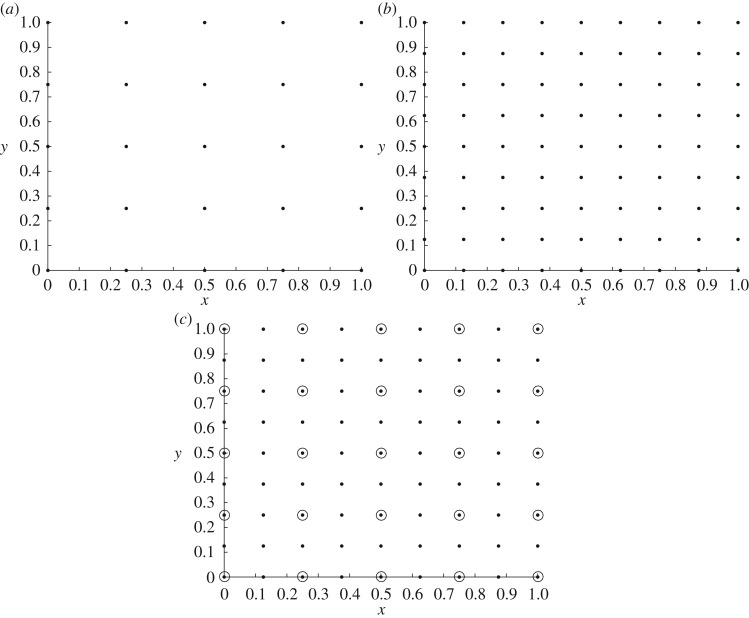
(a) Example of a grid of 25 nodes and (b) a grid of 81 nodes. (c) Grid of 25 nodes (circles) seen as a subgrid of a grid of 81 nodes (dots) for the domain D=[0,1]×[0,1].